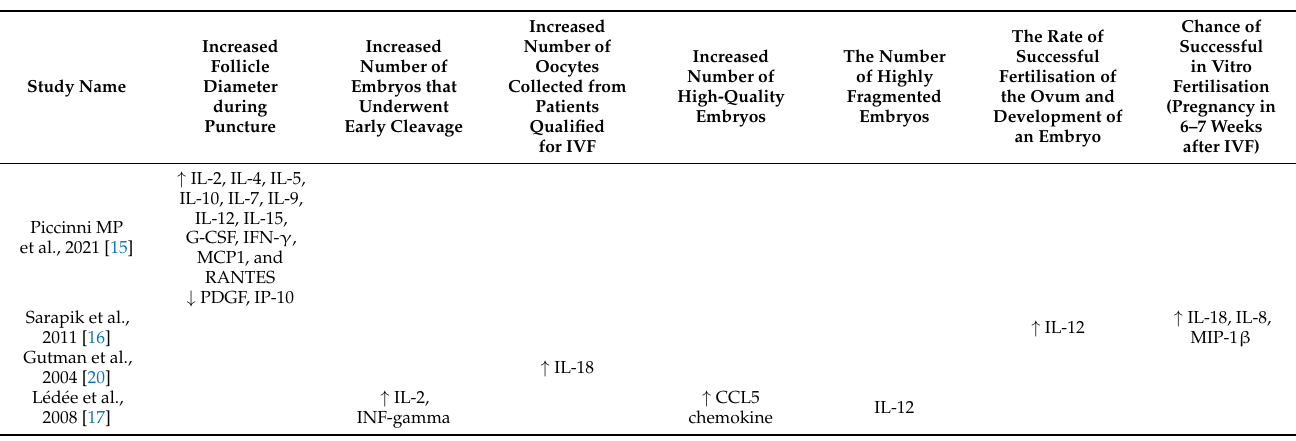
Table 2. Cytokines of follicular fluid and correlation of their concentration with follicular and embryo development during fertility